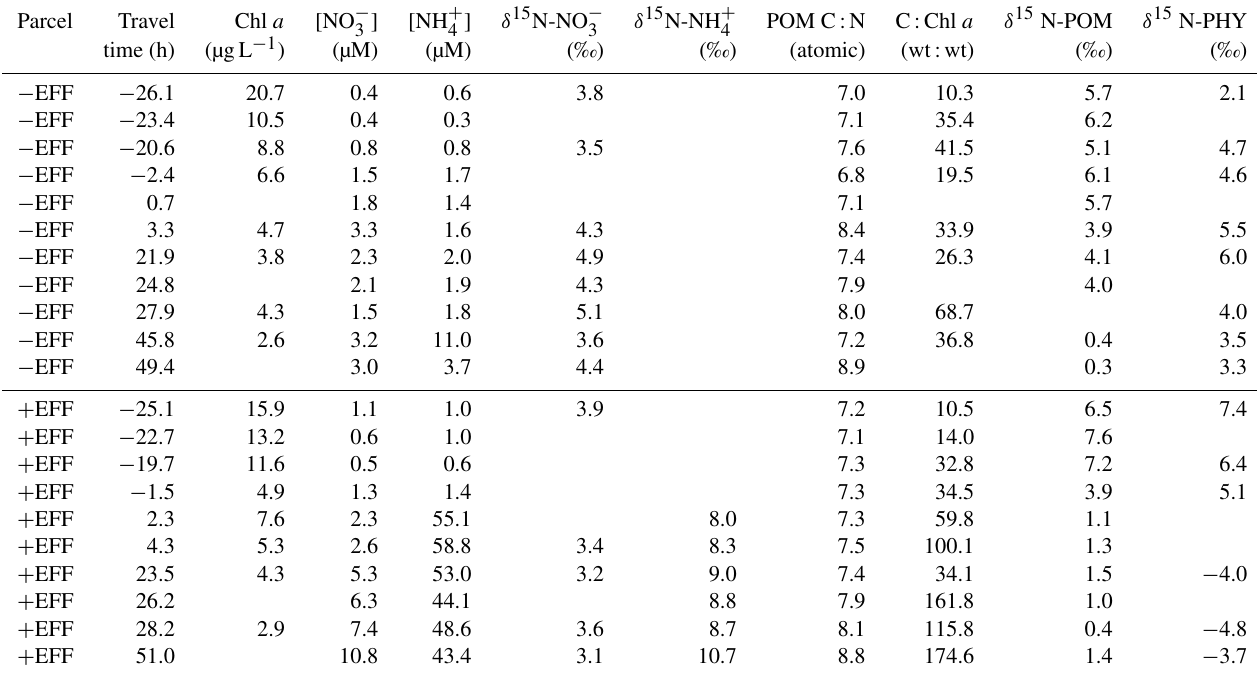
Table 2. Summary of conditions in the two parcels sampled in June 2014; one parcel did not receive effluent ( − EFF) and one parcel did receive effluent ( + EFF) as it passed the wastewater treatment plant (WWTP). A travel time of zero represents the time each parcel passed the location where effluent from the WWTP enters the